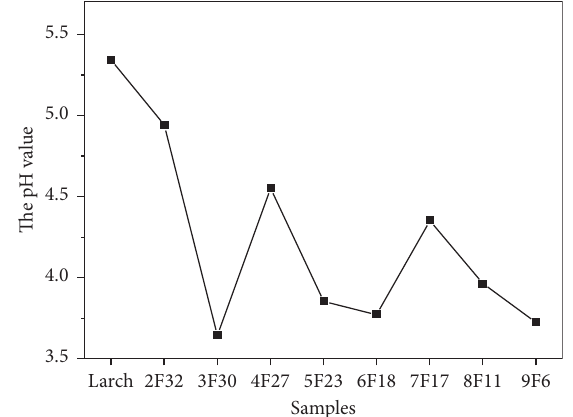
Figure 7: Results of pH measurement of the aged and sound wood samples. The acidity of each aged wood sample is higher than that of the sound